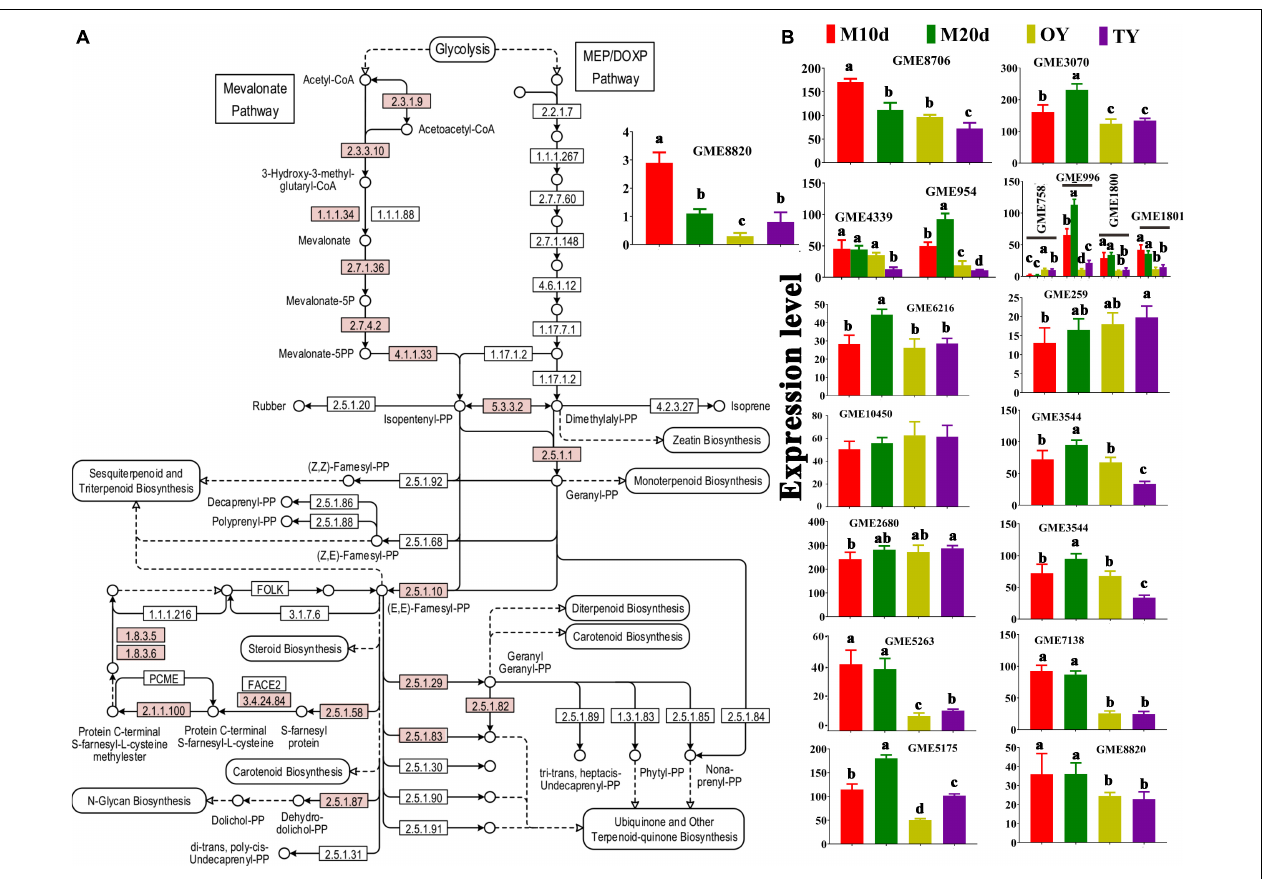
FIGURE 5 | KEGG mapping of the terpenoid backbone biosynthesis pathway and differential expression of the enzymes identified in S. sanghuang Kangneng . (A) The red box indicates existing homologous genes of the enzyme. (B) The expression levels of genes in different developmental stages. Different lowercase letters marked on the bars in each graph denote significant differences ( P <